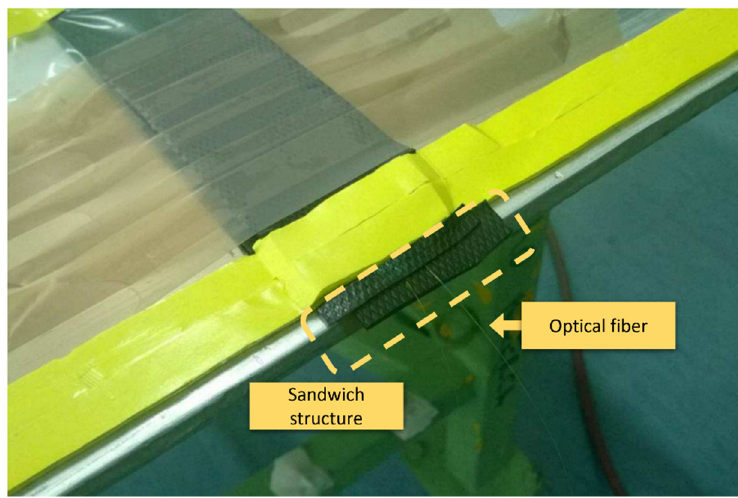
Figure 8. Two optical fibers installed inside and on the skin coming out through the sealed vacuum bag.